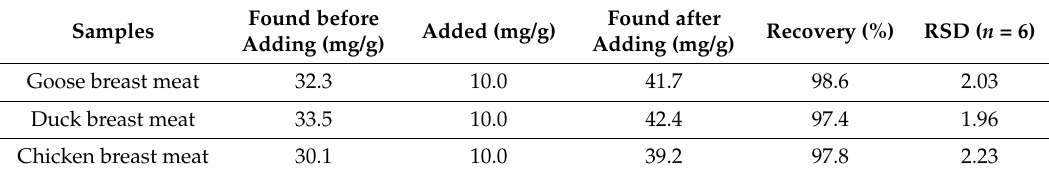
Table 2. Determination of actin in goose, duck and chicken breast meat ( n =